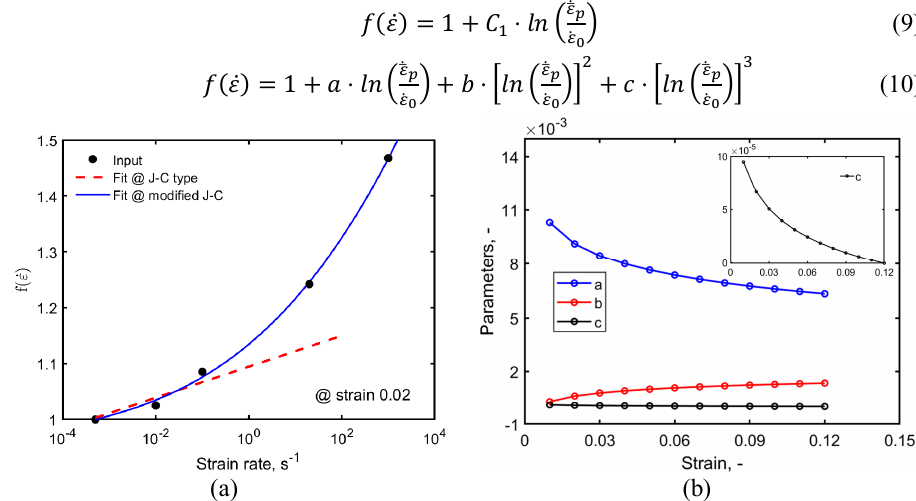
Fig. 7. (a) Strain rate dependence fitting with original J-C and modified J-C strain rate term; (b) Parameters a, b and c for different